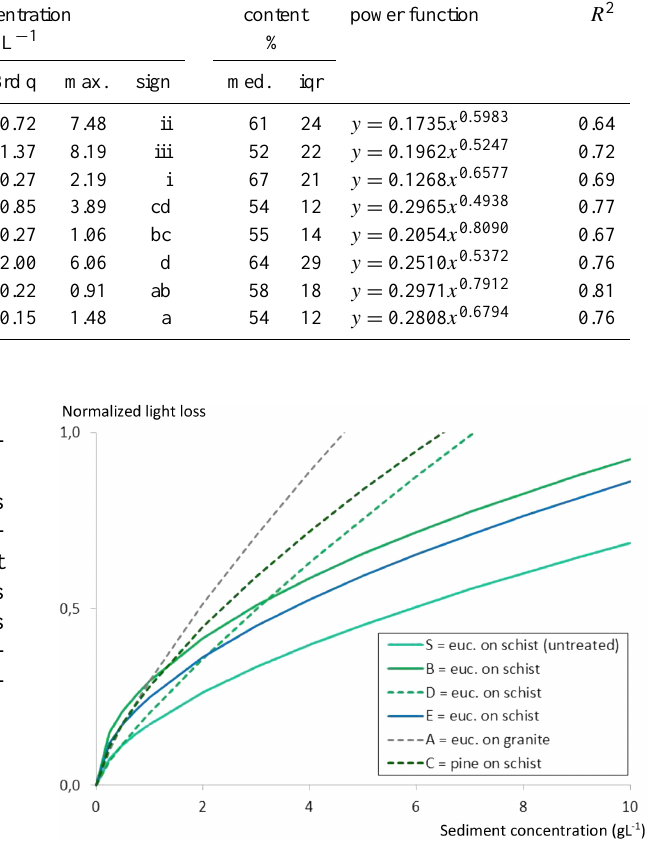
Figure 3. Best-fitting power functions of the relationships of post- fire sediment concentration with normalized light loss at the micro- plot scale for one pine plantation on schist and five eucalypt (euc.) plantations on schist or granite (see Table